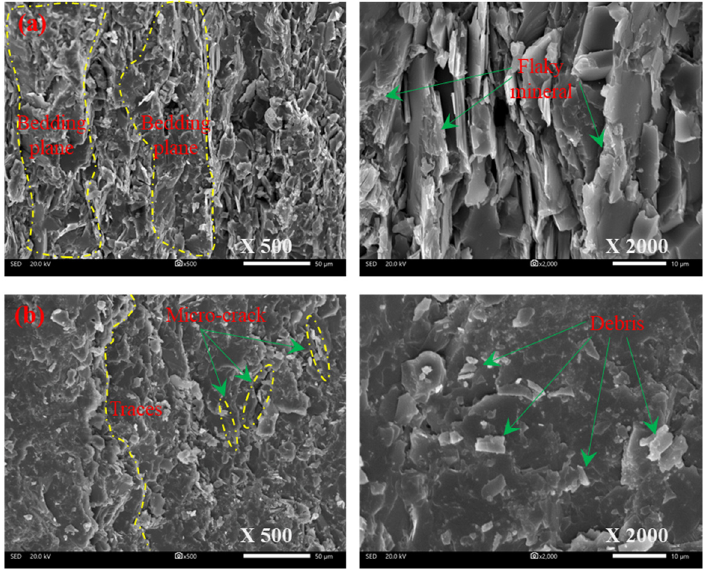
Figure 16. SEM photos of the fracture surfaces for phyllite subjected to tensile failure in uniaxial compression: ( a ) S-D-0; ( b ) S-D-90. compression: ( a ) S-D-0; ( b )